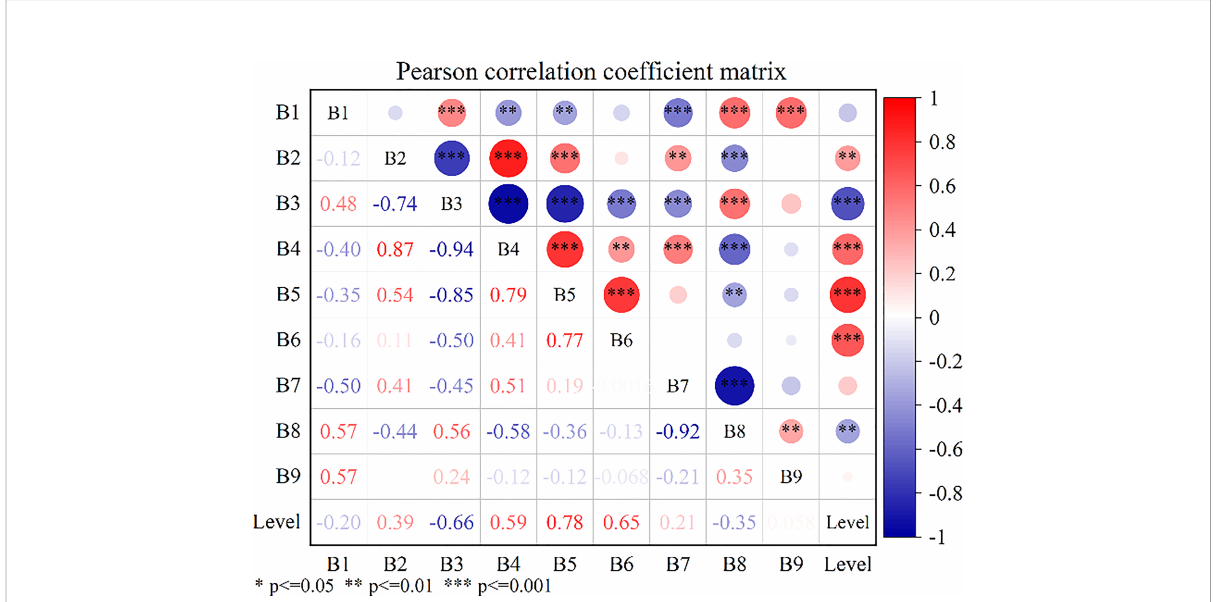
FIGURE 9 Pearson correlation analysis results of aphid infestation severity and DRS value in Sentinel-2 multispectral images. (* represents signi fi cant at the 0.05 level; ** represents signi fi cant at the 0.01 level; *** represents signi fi cant at the 0.001